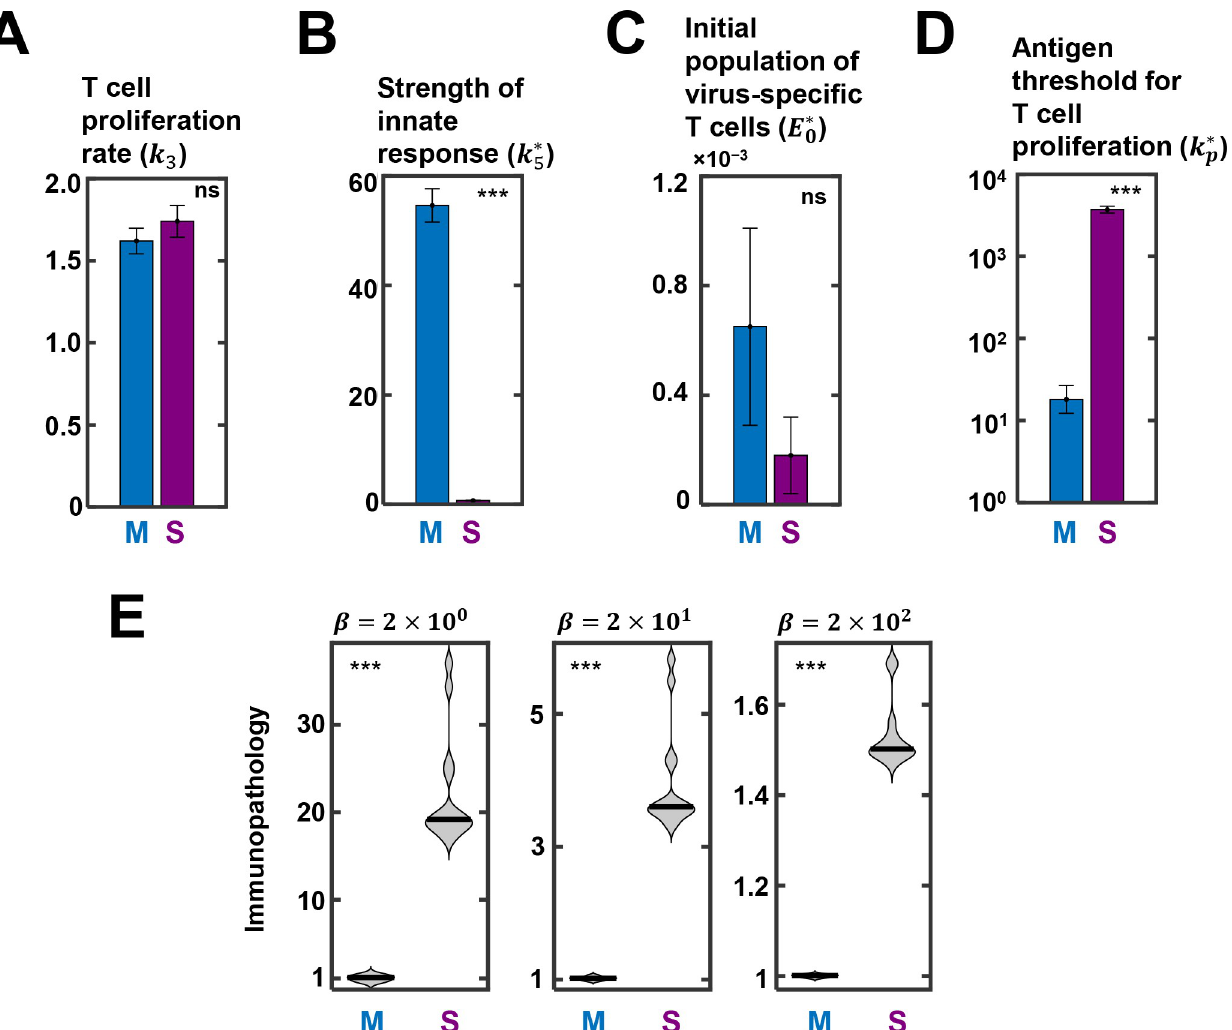
Fig 6. Comparison of parameter estimates between mildly and severely infected patients. Best-fit estimate of (A) T cell proliferation rate ( k 3 ), (B) strength of innate response ( k � ), (C) initial population of virus-specific T cells ( E � ), (D) antigen threshold for T cell proliferation ( k � ) between mildly (M) and severely 5 0 p (S) infected patients (see Fig 5). ns: not significant, ��� : p < 0.0001. (E) The distributions of model-predicted immunopathology of the two patient cohorts using different values of β , reflecting the relative contribution of cytokines to immunopathology. The solid lines in the violin plots are medians.